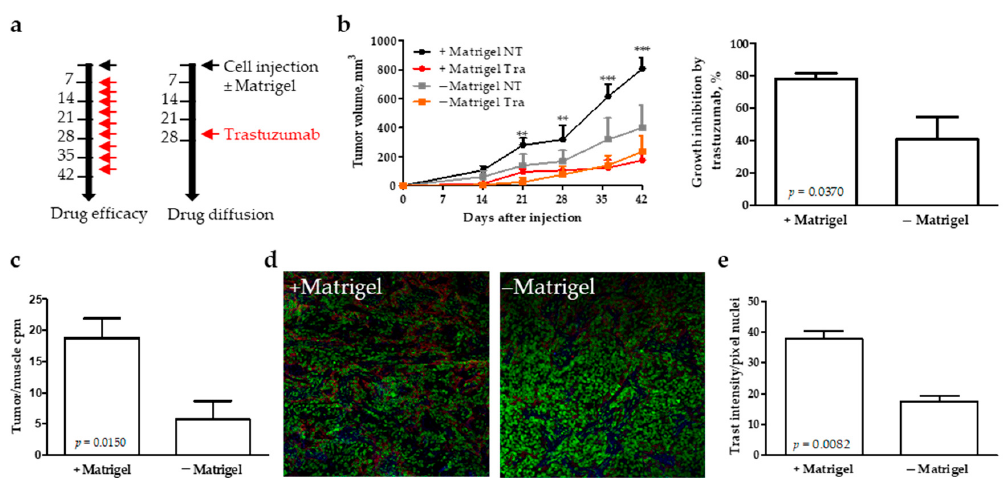
Figure 4. Role of extracellular matrix density in trastuzumab efficacy. ( a ) Scheme of the in vivo experiments. ( b ) Tumor volume and percent tumor growth inhibition by trastuzumab at day 42 in tumors obtained from injection of cells with ( + Matrigel) or without ( − Matrigel) Matrigel. Data are mean ± SD ( n = 4). ( c ) 131 I-Trastuzumab quantification in tumors obtained from injection of cells in mice with ( + Matrigel) or without ( − Matrigel) Matrigel 48 h after treatment with 131 I-Trastuzumab. Data are mean ± SD of the ratio between radioactivity (count per minute) quantified in the tumor and in the muscle of the same mouse ( n = 5). ( d ) Representative images of trastuzumab localization evaluated by immunofluorescence in tumors of mice injected with cells embedded ( + ) or not ( − ) in Matrigel (red: trastuzumab, green: sybr green, nuclei, blue: collagen). ( e ) Trastuzumab quantification in tumors grown with ( + ) or without ( − ) Matrigel 24 h after treatment. Data are mean ± SD ( n = 4) of the mean fluorescence intensities of red positive pixels normalized on the number of green pixels (nuclei). p -values by unpaired t -test.